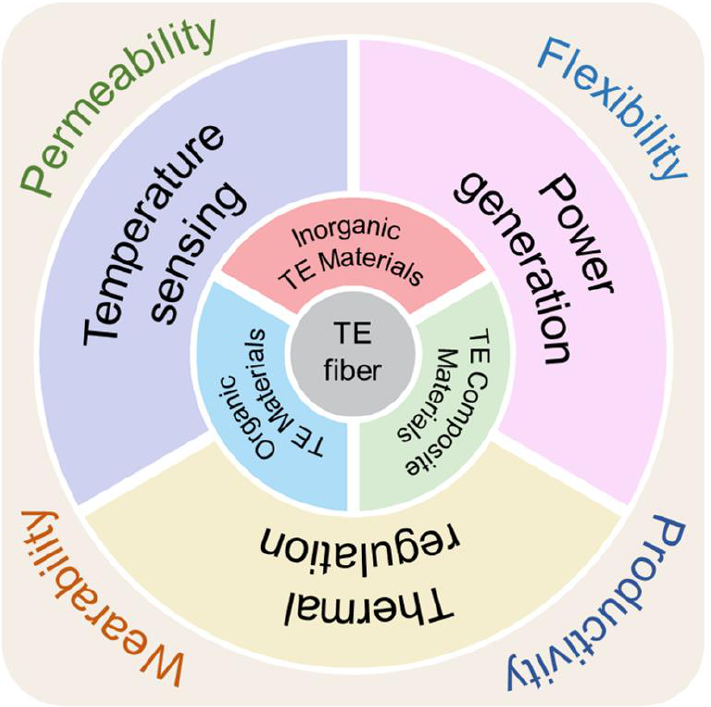
Figure 1. Fiber-based thermoelectric materials and devices for application in wearable electronics.